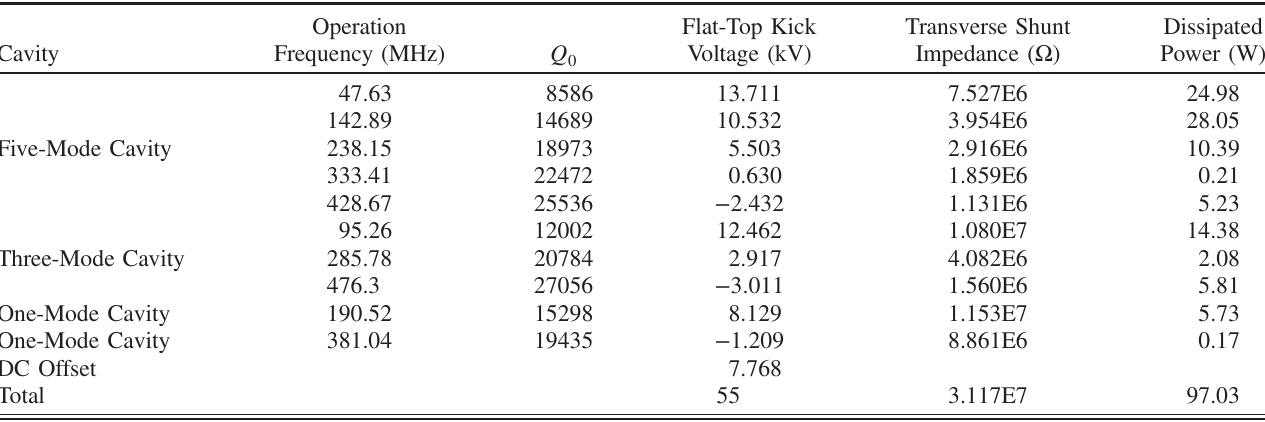
TABLE I. Calculated electromagnetic parameters of each mode for room temperature copper.